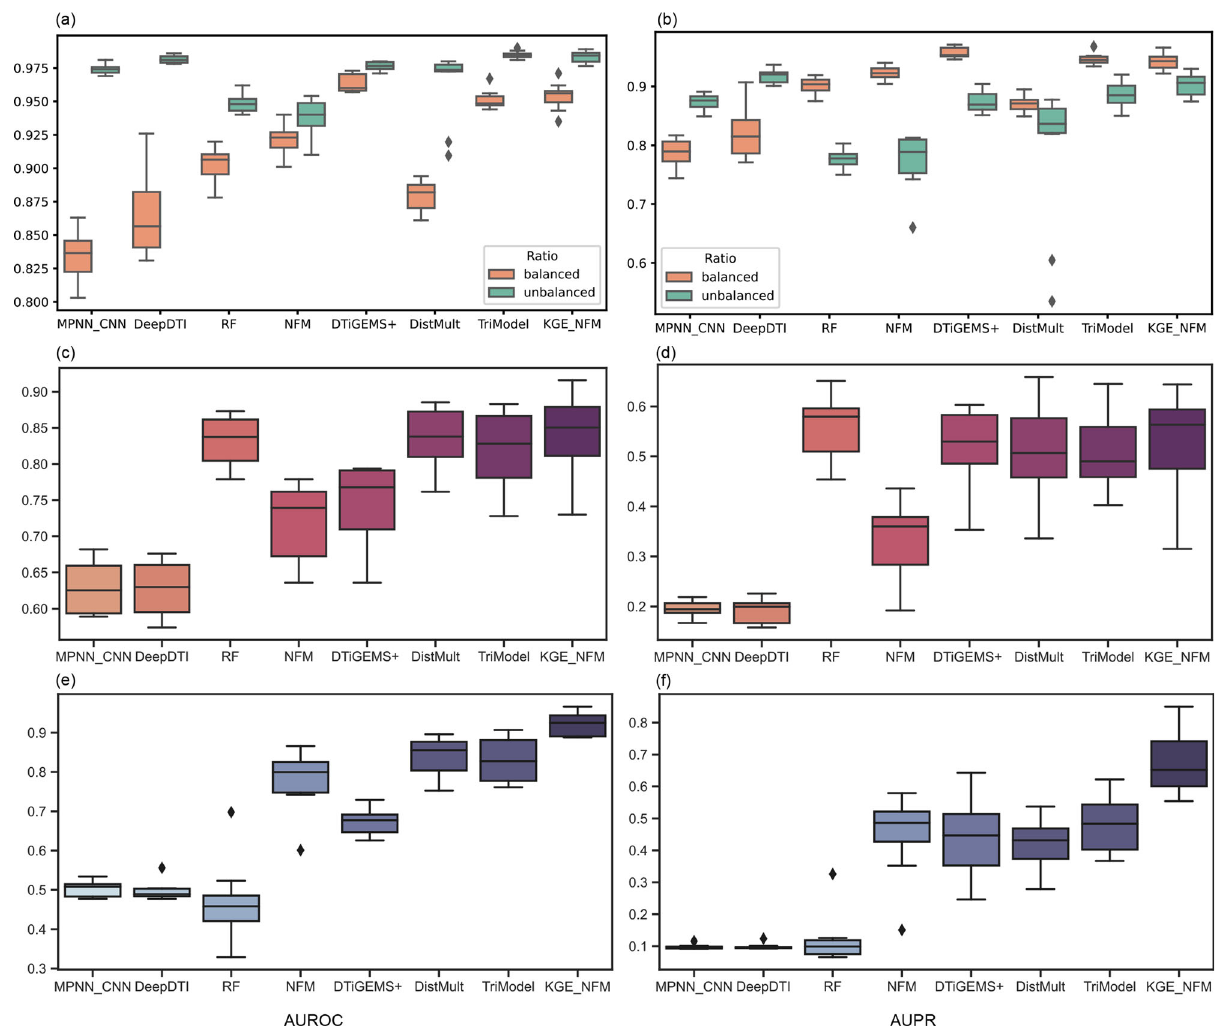
Fig. 2 Evaluation performance on the Yamanishi_08 ’ s dataset in three sample scenarios. All results were obtained by 10-fold cross-validation. The predictive performance in the scenario of the warm start (Fig. 2a, b) was evaluated with two different ratios between positive and negative samples, in which the ‘ balanced ’ means positive:negative (cid:1) 1:1 and the ‘ unbalanced ’ means positive:negative (cid:1) 1:10. The predictive performance in the scenario of cold start (Fig. 2c – f) was evaluated in the unbalanced situation. N = 10 independent experiments. Box plots show the median as the center lines, upper and lower quartiles as box limits, whiskers as maximum and minimum values, and dots represent